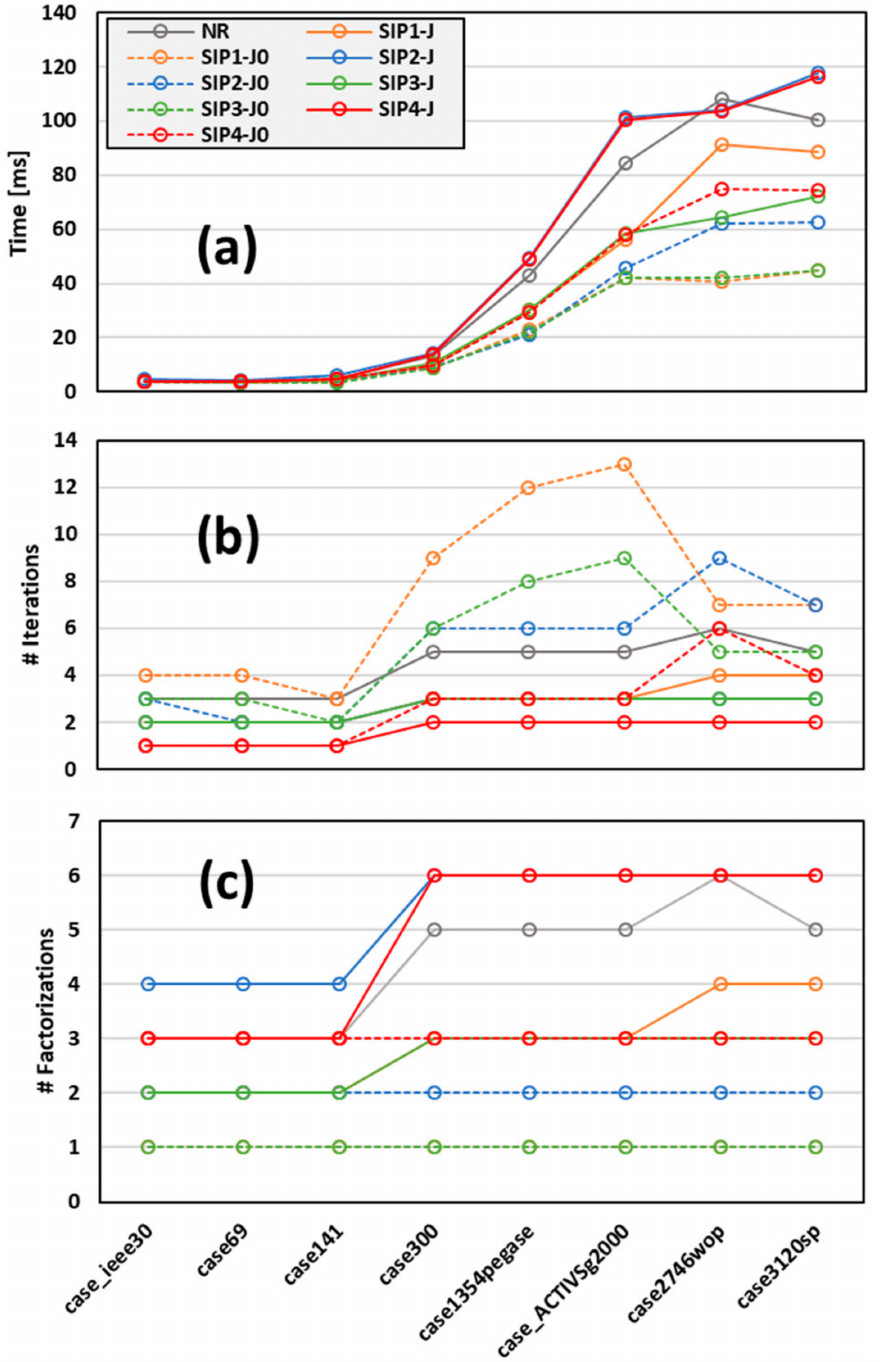
Figure 4. Comparison of the results obtained in well-conditioned systems. ( a ) Execution time (ms), ( b ) total iterations, and ( c ) total